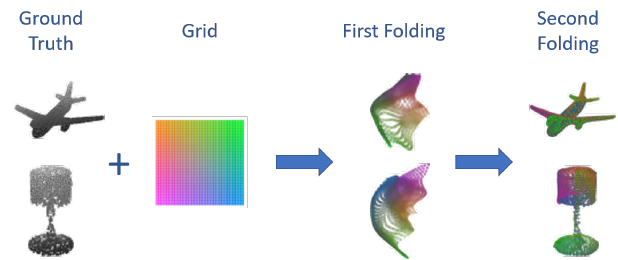
Figure 15. Examples of PCs and their reconstruction